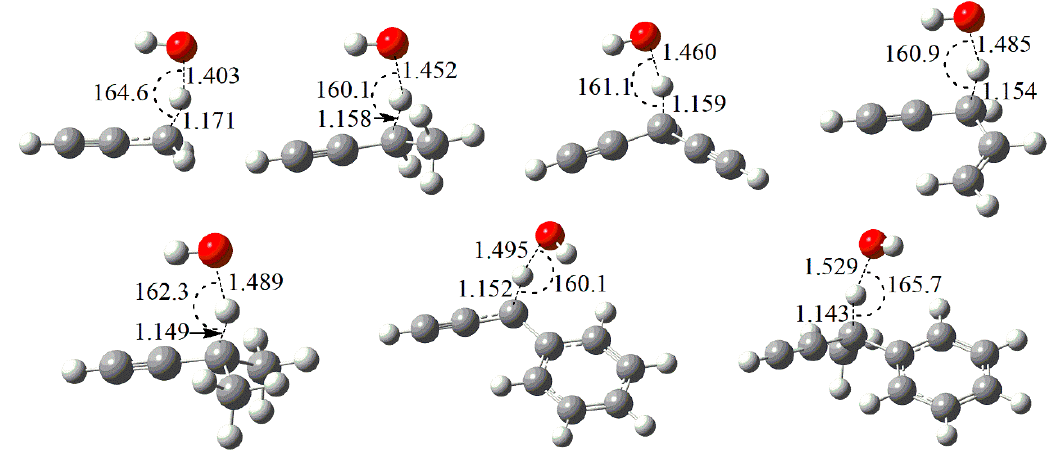
Figure 2. Optimized geometries (in Å and degrees) of TSs for the studied abstraction reactions by OH radical at M06-2X/cc-pVTZ level. The geometry centers of TS for 1-pentyne are identical to that of 1-butyne, and thus not explicitly shown.